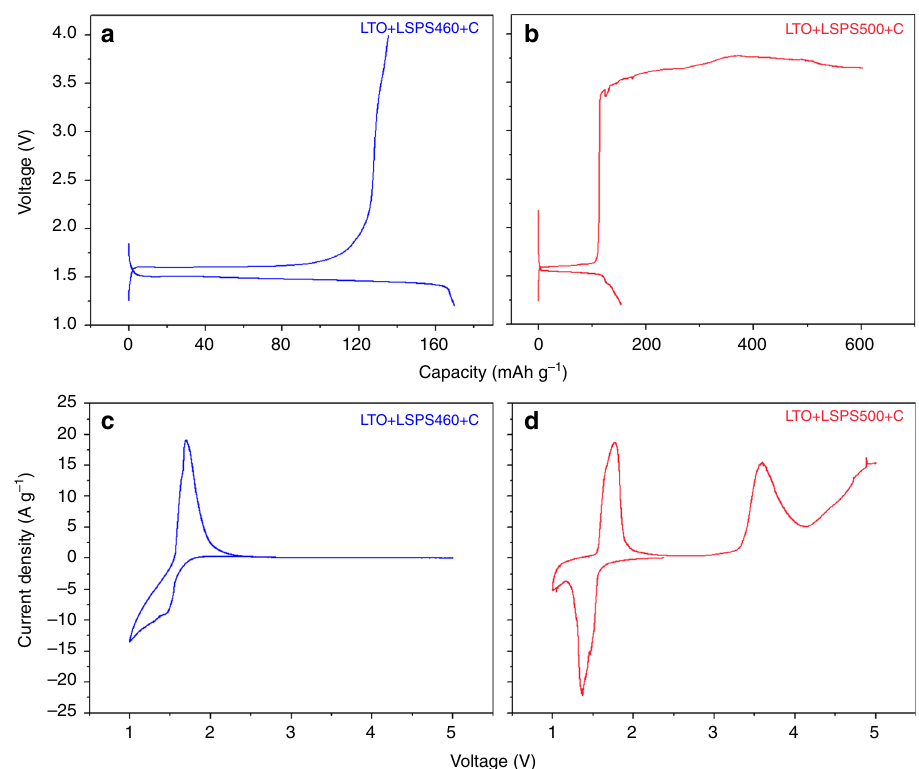
Fig. 5 Battery performance and CV test results of all-solid-state batteries using: a , c LTO + LSPS460 + C as cathode, LGPS as solid electrolytes and LPS- coated lithium foil as anode. b , d The same tests for LSPS500. Current rate for battery test is 0.1 C. Sweeping rate for CV test is 0.1 mV s –